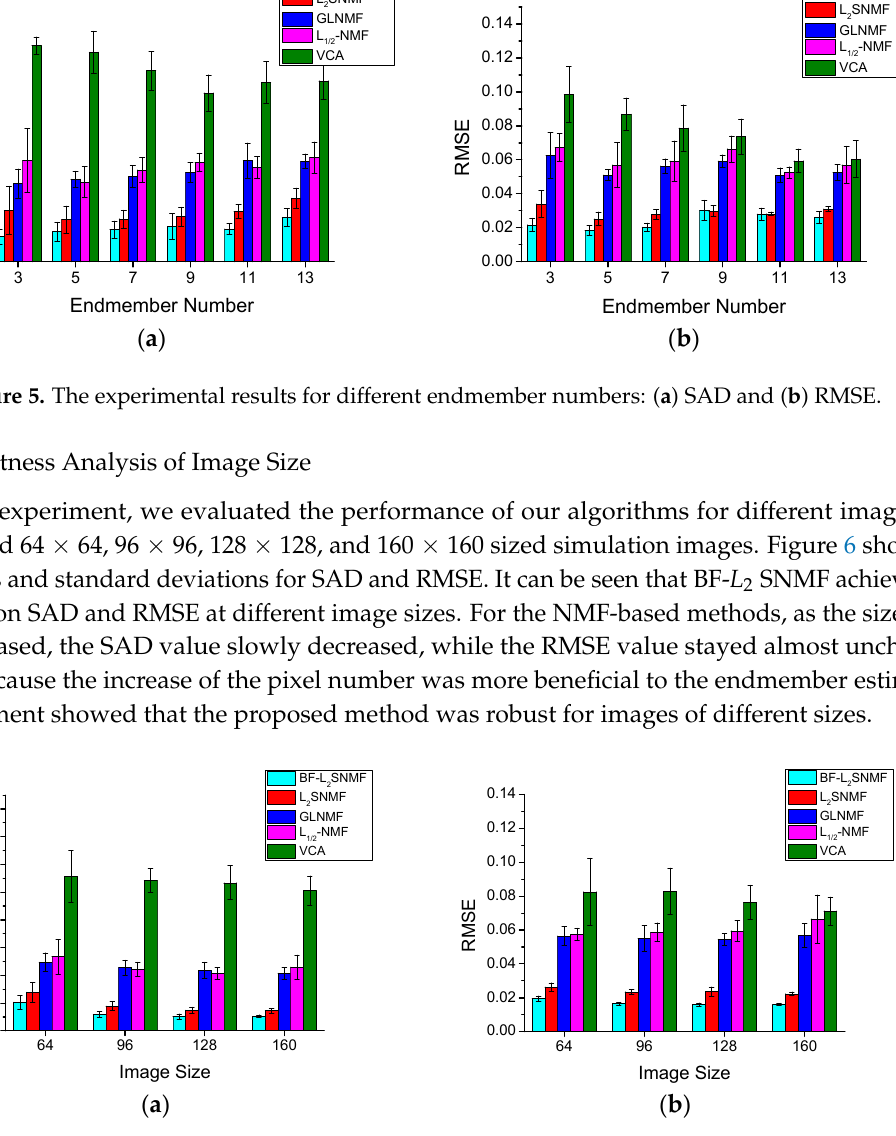
Figure 6. The experimental results for different image sizes: ( a ) SAD and ( b ) RMSE.